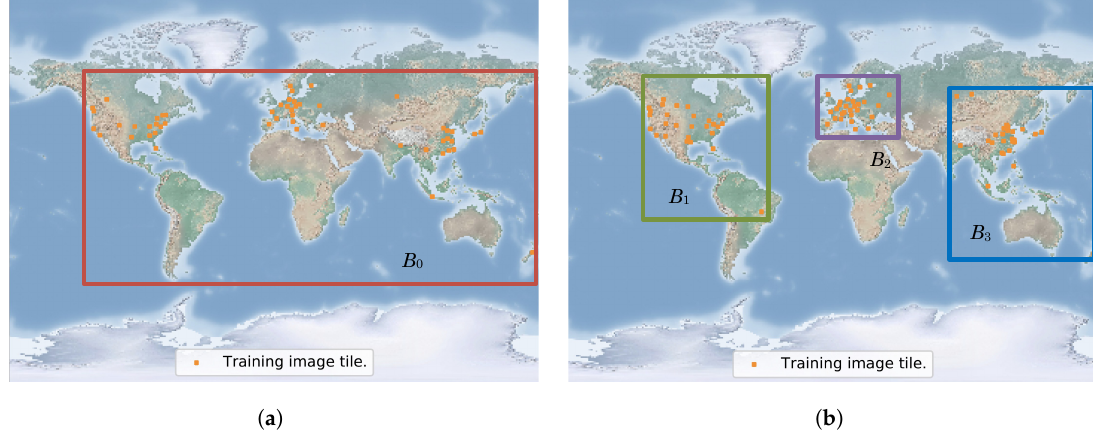
Figure 3. Geospatial distribution of data sets in different areas. The figure of ( a ) is the bounding box of the data group x 0 , and the figure of ( b ) is the bounding boxes of the data groups x 1 , x 2 , and x 3 . Each group is divided equally in terms of the number of image tiles, and the corresponding colored boxes are their coverage range. The bounding boxes of data groups x 0 , x 1 , x 2 , and x 3 are B 0 , B 1 , B 2 , and B 3 colored with red, green, purple, and blue,